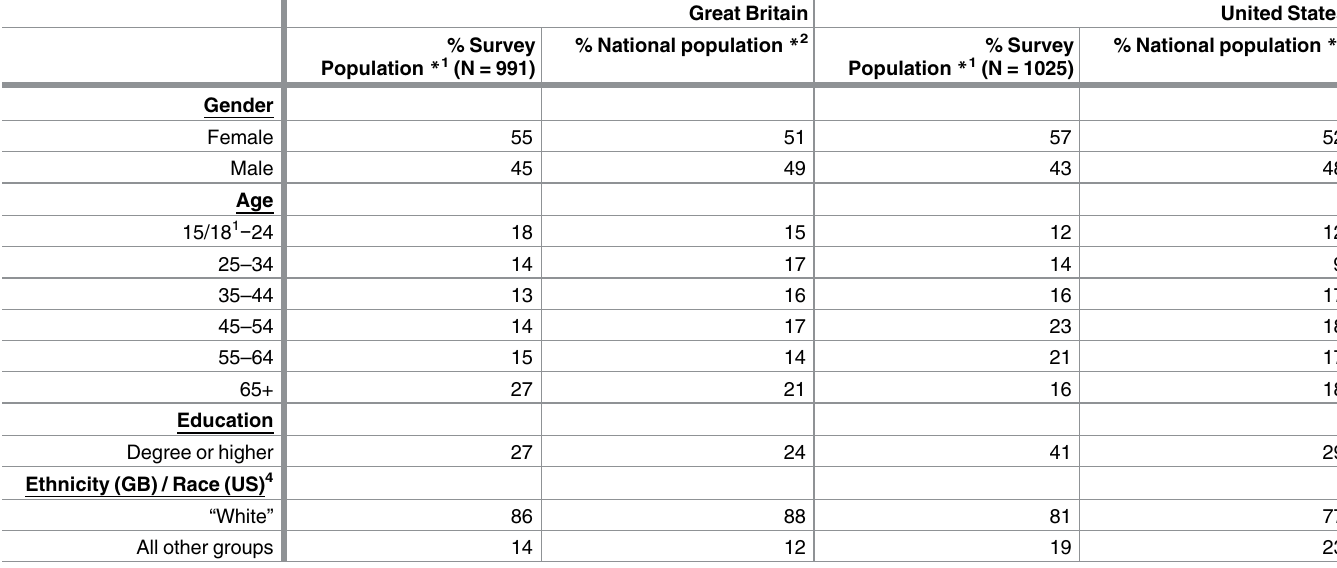
Table 1. Unweighted survey population percentages (N = 2016) and estimated percentage national population